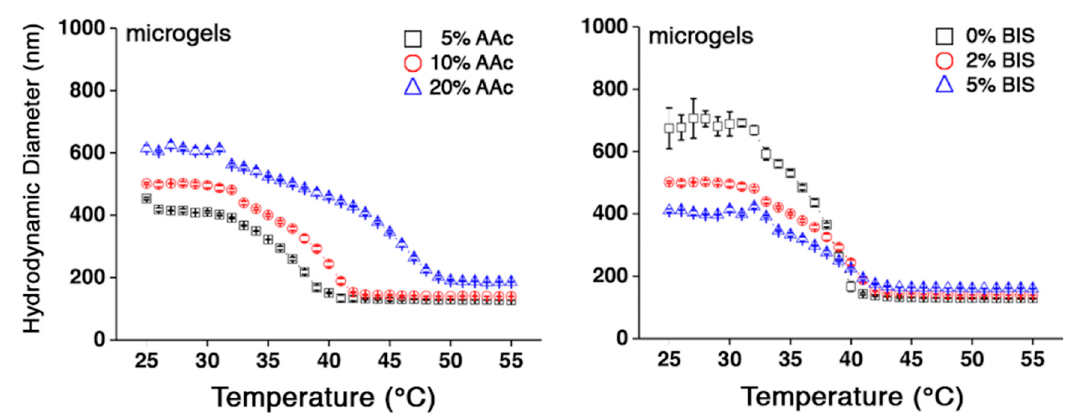
Figure 7. VPTT of hydrogel nanoparticles as a function of AAc and BIS contents in the hydrogel nanoparticles [136] . Reproduced from [136] with permission. Copyright (2018) MDPI AG.